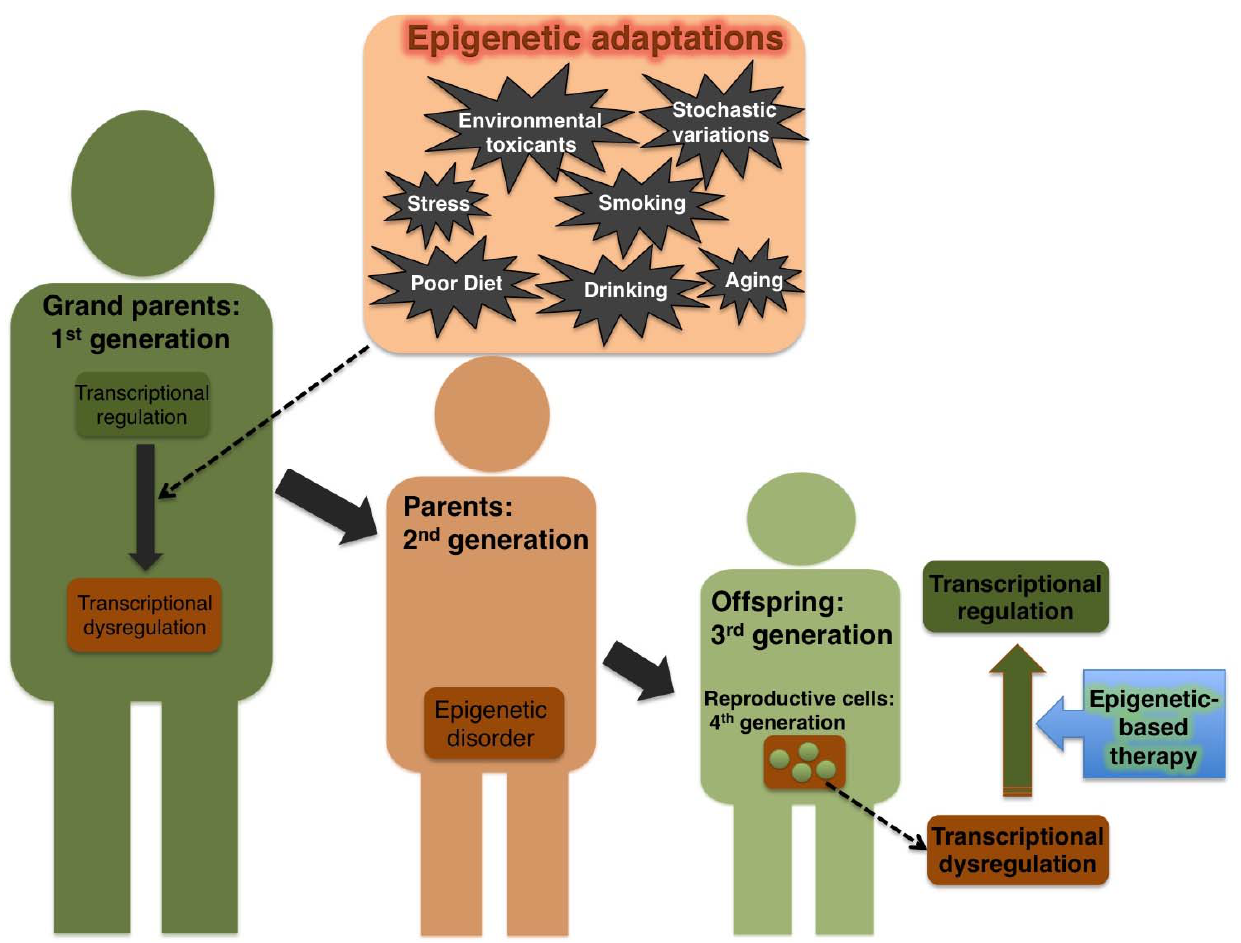
Figure 1. Transgenerational inheritance of epigenetic marks that leads to transcriptional dysregulation. Disadvantageous external stimuli (indicated in cream box) could cause aberrant regulation of the epigenome. The acquired epigenetic disorder (indicated in the red box) can be transmitted across generations from grand parents to their offspring. Epigenetic-based therapeutic approach may pave the way to restore this acquired transcriptional dysregulation even in the later generations (Restored transcriptional regulation is shown in green